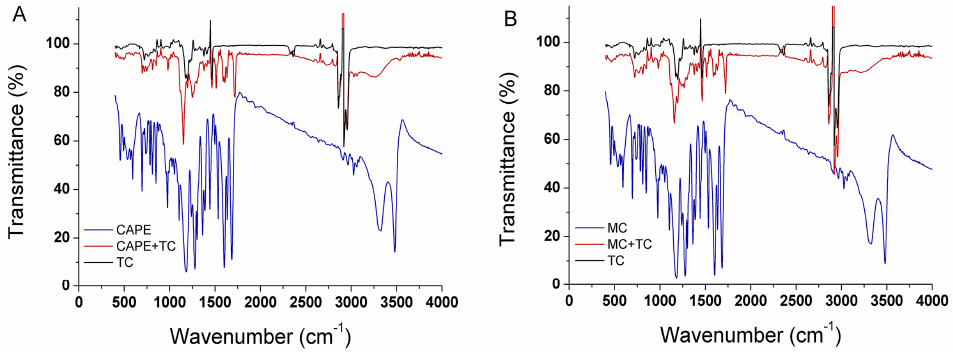
Figure 5. IR spectra of TOPO before and after complexation with CAPE ( A ) and MC ( B ) in 30 g/L